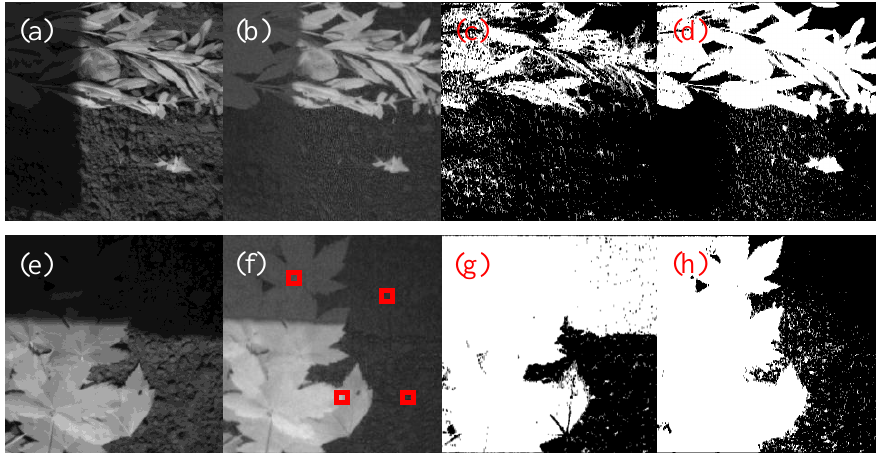
Figure 12. ( a ) Raw image of a high dynamic range situation of soil covered piecewise by leafs, ( b ) the applied reNDVI, ( c ) binary image of the NDVI, ( d ) binary image of the reNDVI, ( e ) raw image of a high dynamic range situation of soil covered piecewise by leafs, ( f ) the applied reNDVI, ( g ) binary image of the NDVI, and ( h ) binary image of the reNDVI. All binary images are five-point Gaussian filtered results.